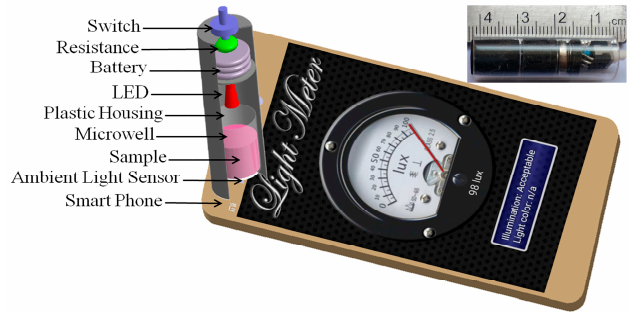
Figure 1. Schematic illustration of the microwell reader installed on an Android-based smartphone and image of the actual optical microwell reader.